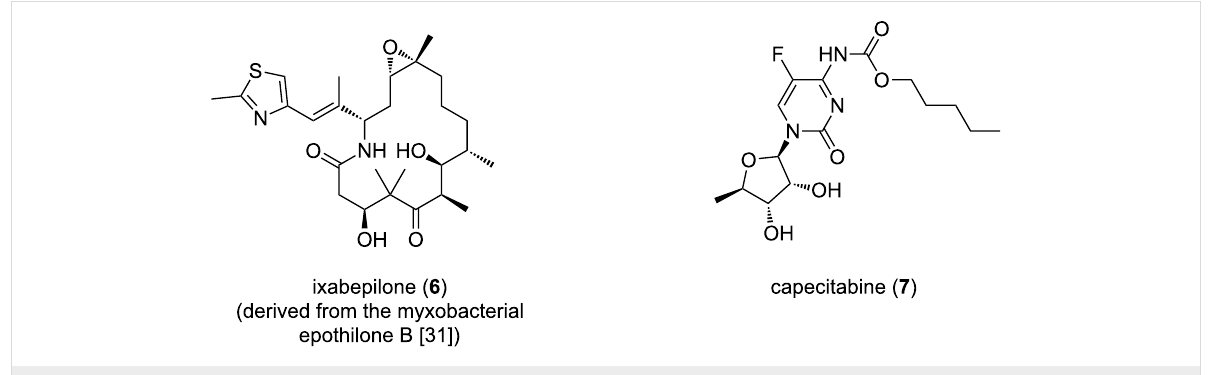
Figure 3: Structures of ixabepilone and capecitabine.